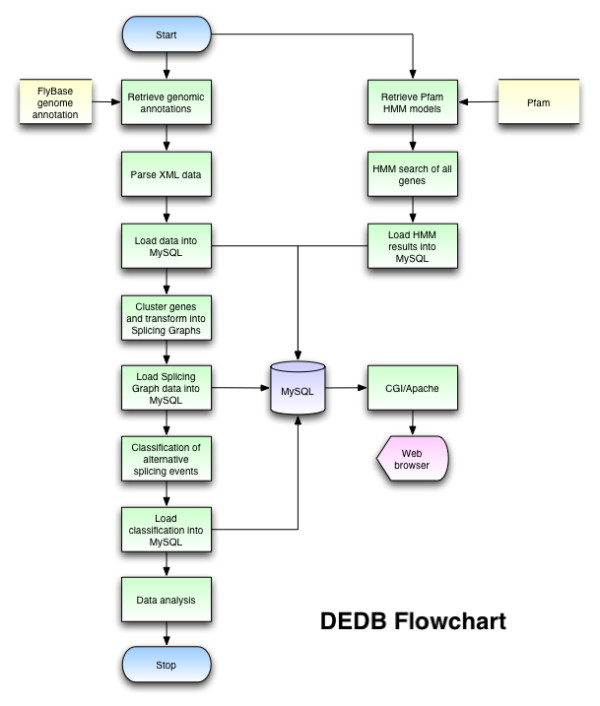
Flowchart depicting the process used to generate DEDB. Processes and data sources are coloured green and yellow respectively. The main data store is a MySQL server and the data housed is exposed to users using HTML pages and CGI (Common Gateway Interface) served by an Apache web server.